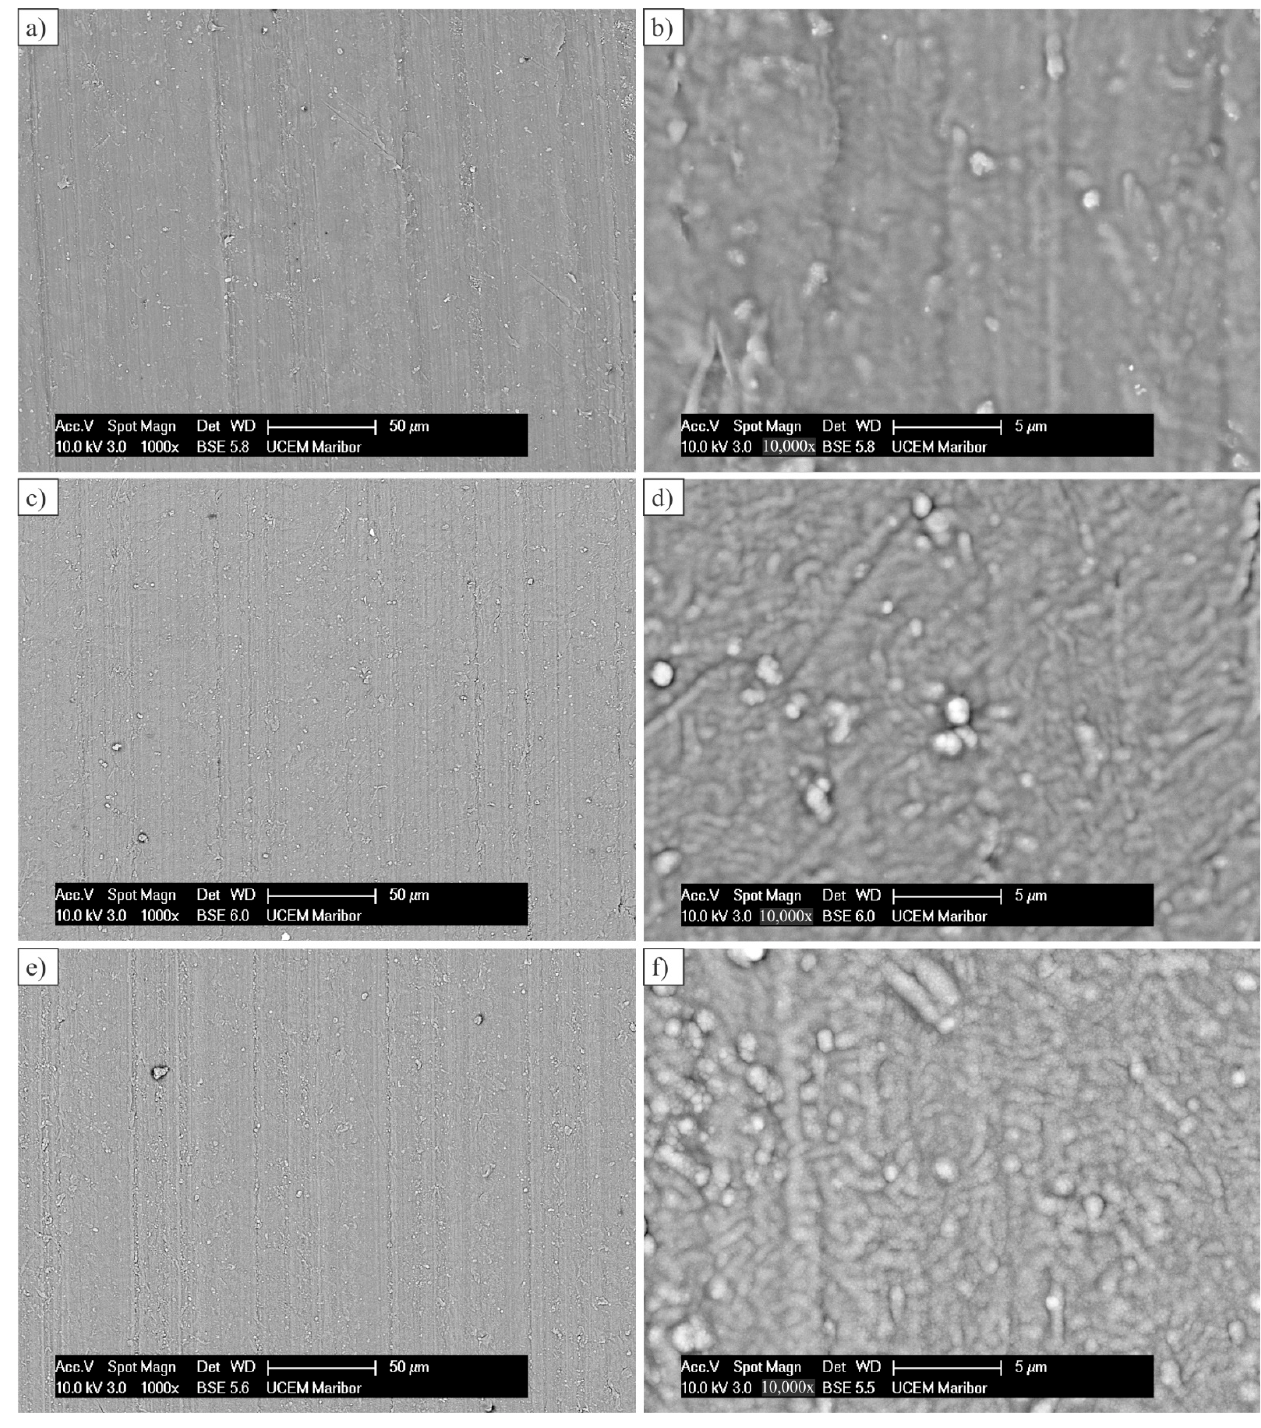
Figure 4. Coated gear surfaces at two magnifications: ( a ), ( b ) One coating layer; ( c ), ( d ) Three coating layers; ( e ), ( f ) Five coating layers.